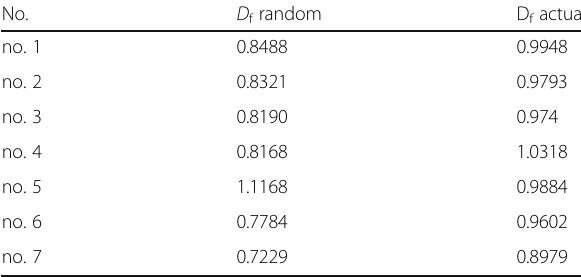
Table 3 Compared to D f in random and actual length